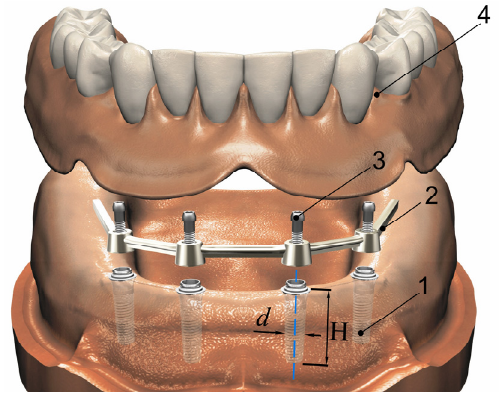
Figure 1. Four implant-retained mandibular bar overdenture scheme: 1—implant; 2—bar; 3—screw; 4—removable overdenture; H and d are the length and the diameter of implant.